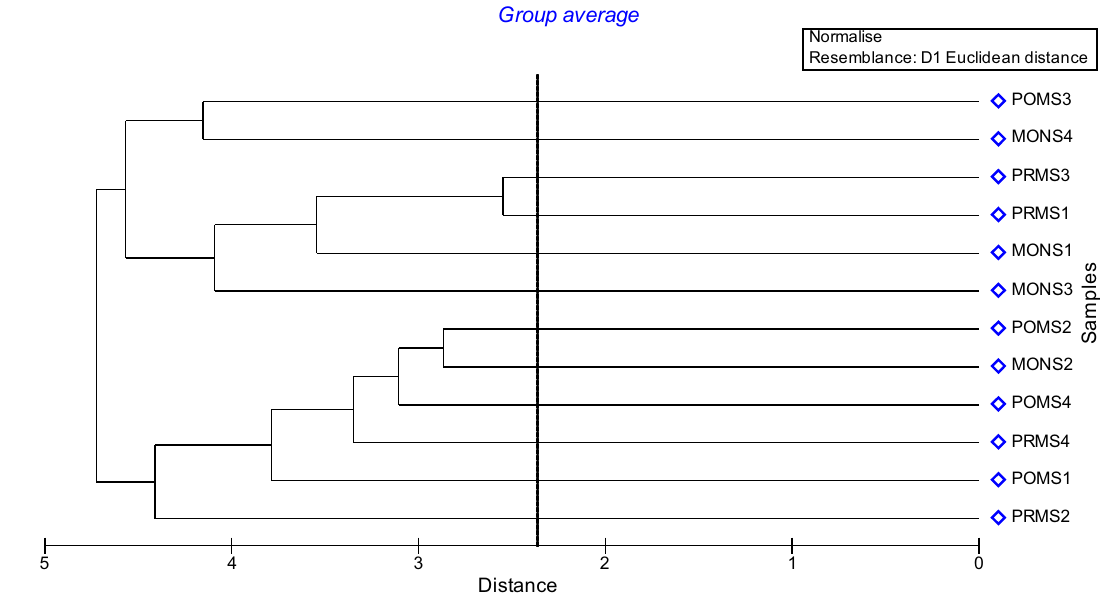
Fig. 2 Dendogram showing the similarity of stations in seasons